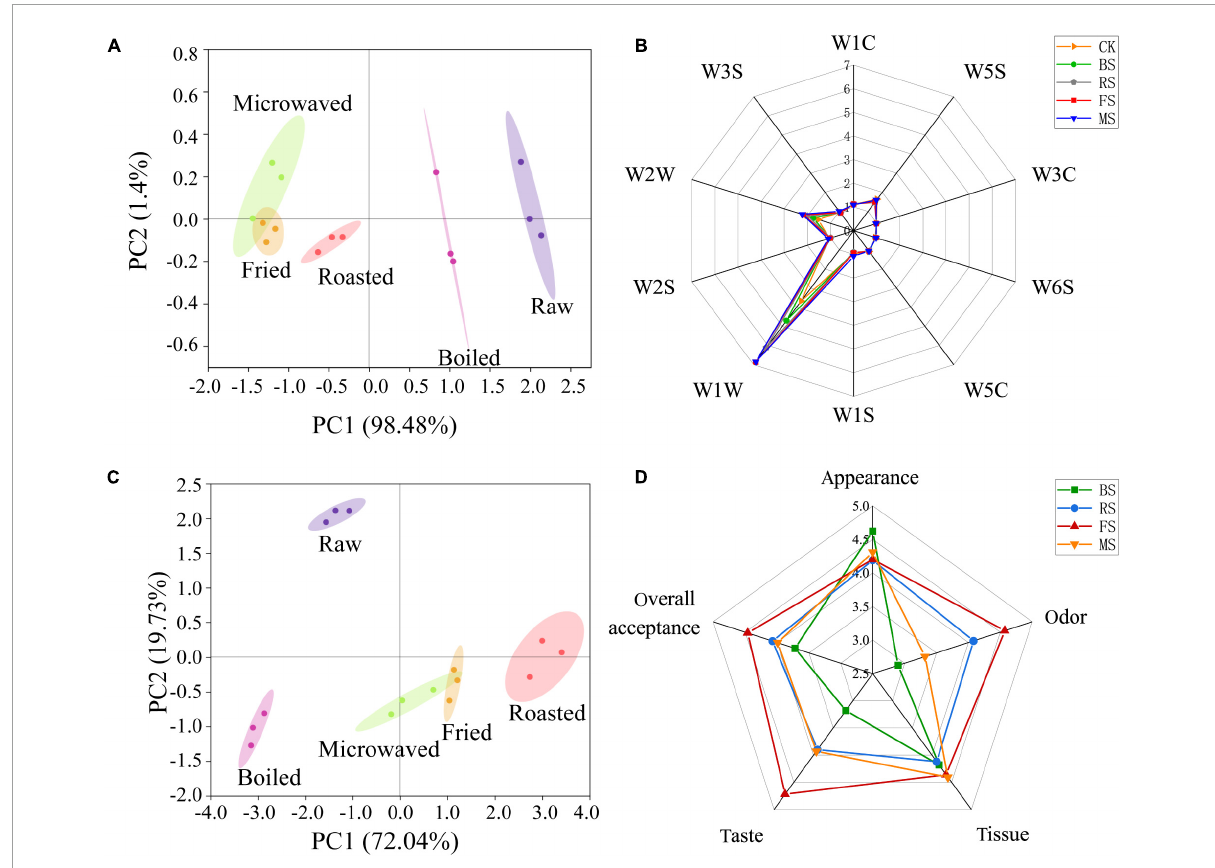
FIGURE3 Electronic nose, electronic tongue, and sensory evaluation analysis of raw and cooked scallops. (A) Principal component analysis of electronic nose results. (B) Radar graph of electronic nose results. (C) Principal component analysis of electronic tongue results. (D) Radar graph of sensory evaluation results (CK, the control group; BS, boiled sample; RS, oven heated sample; FS, fried sample; MS, microwaved